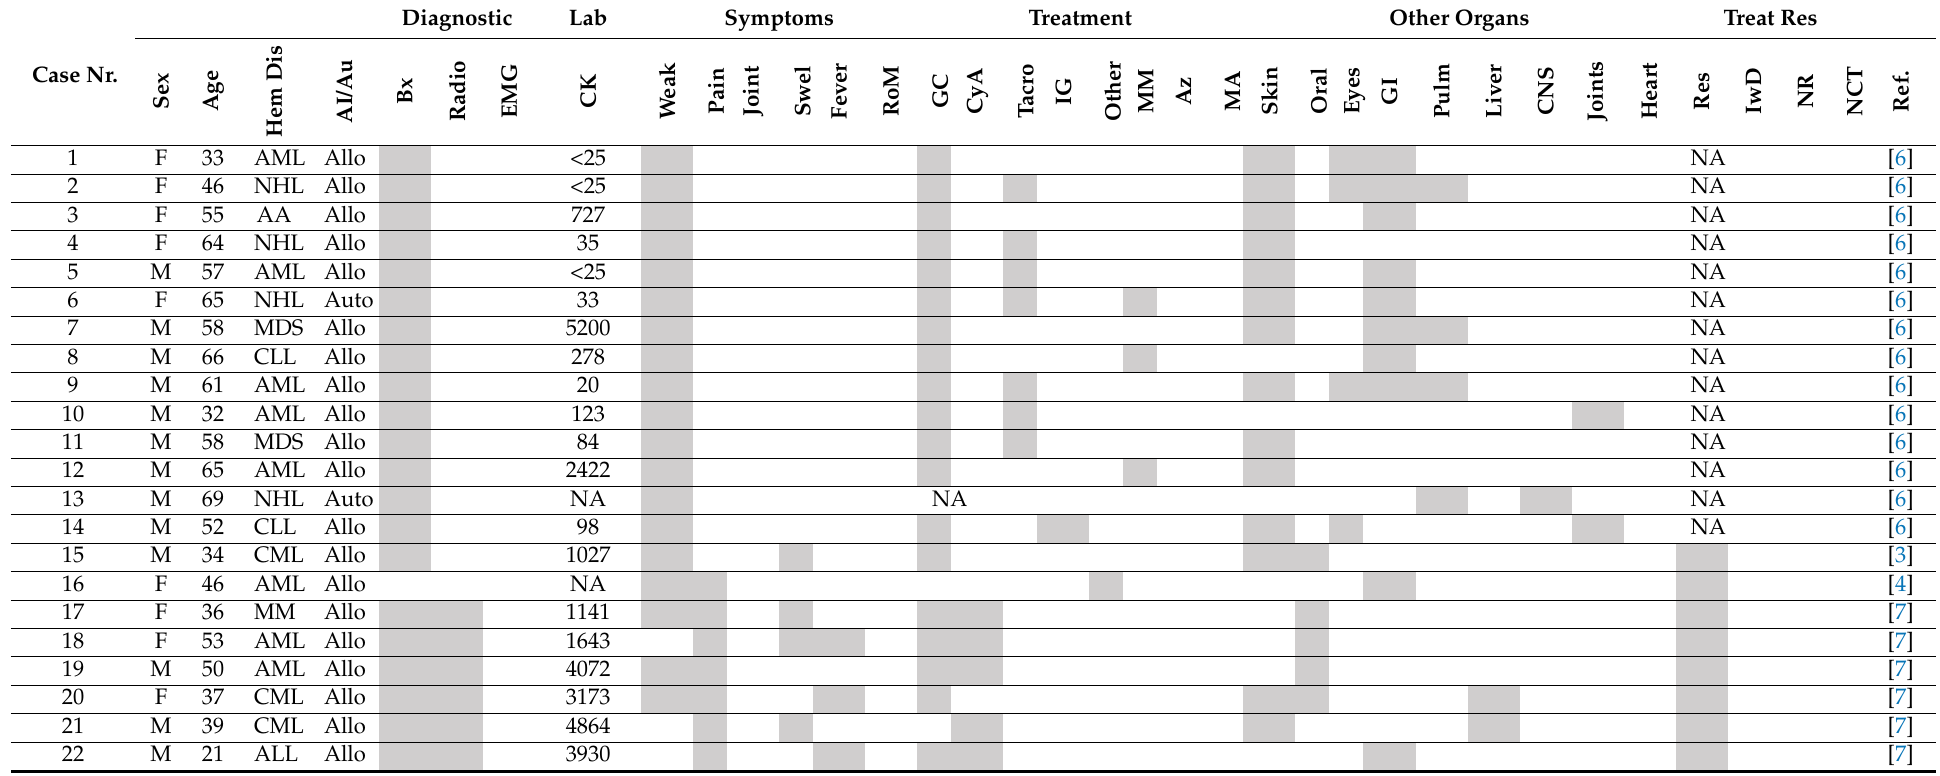
Table 2. Overview of the literature